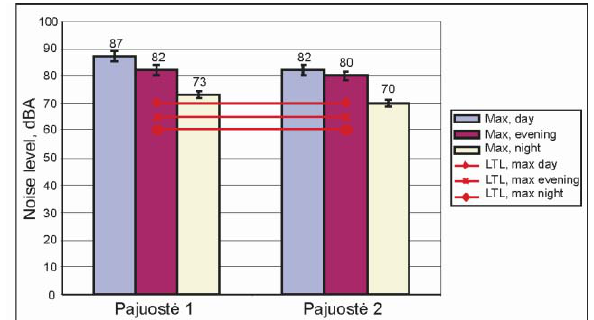
Fig. 23. Dynamics of maximum noise levels in Pajuostė street within twenty four hours